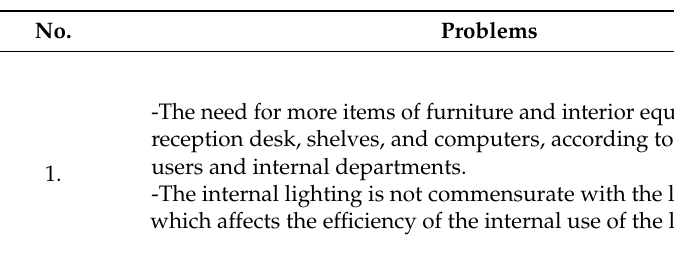
Table 1. The problems of interior design in the academic